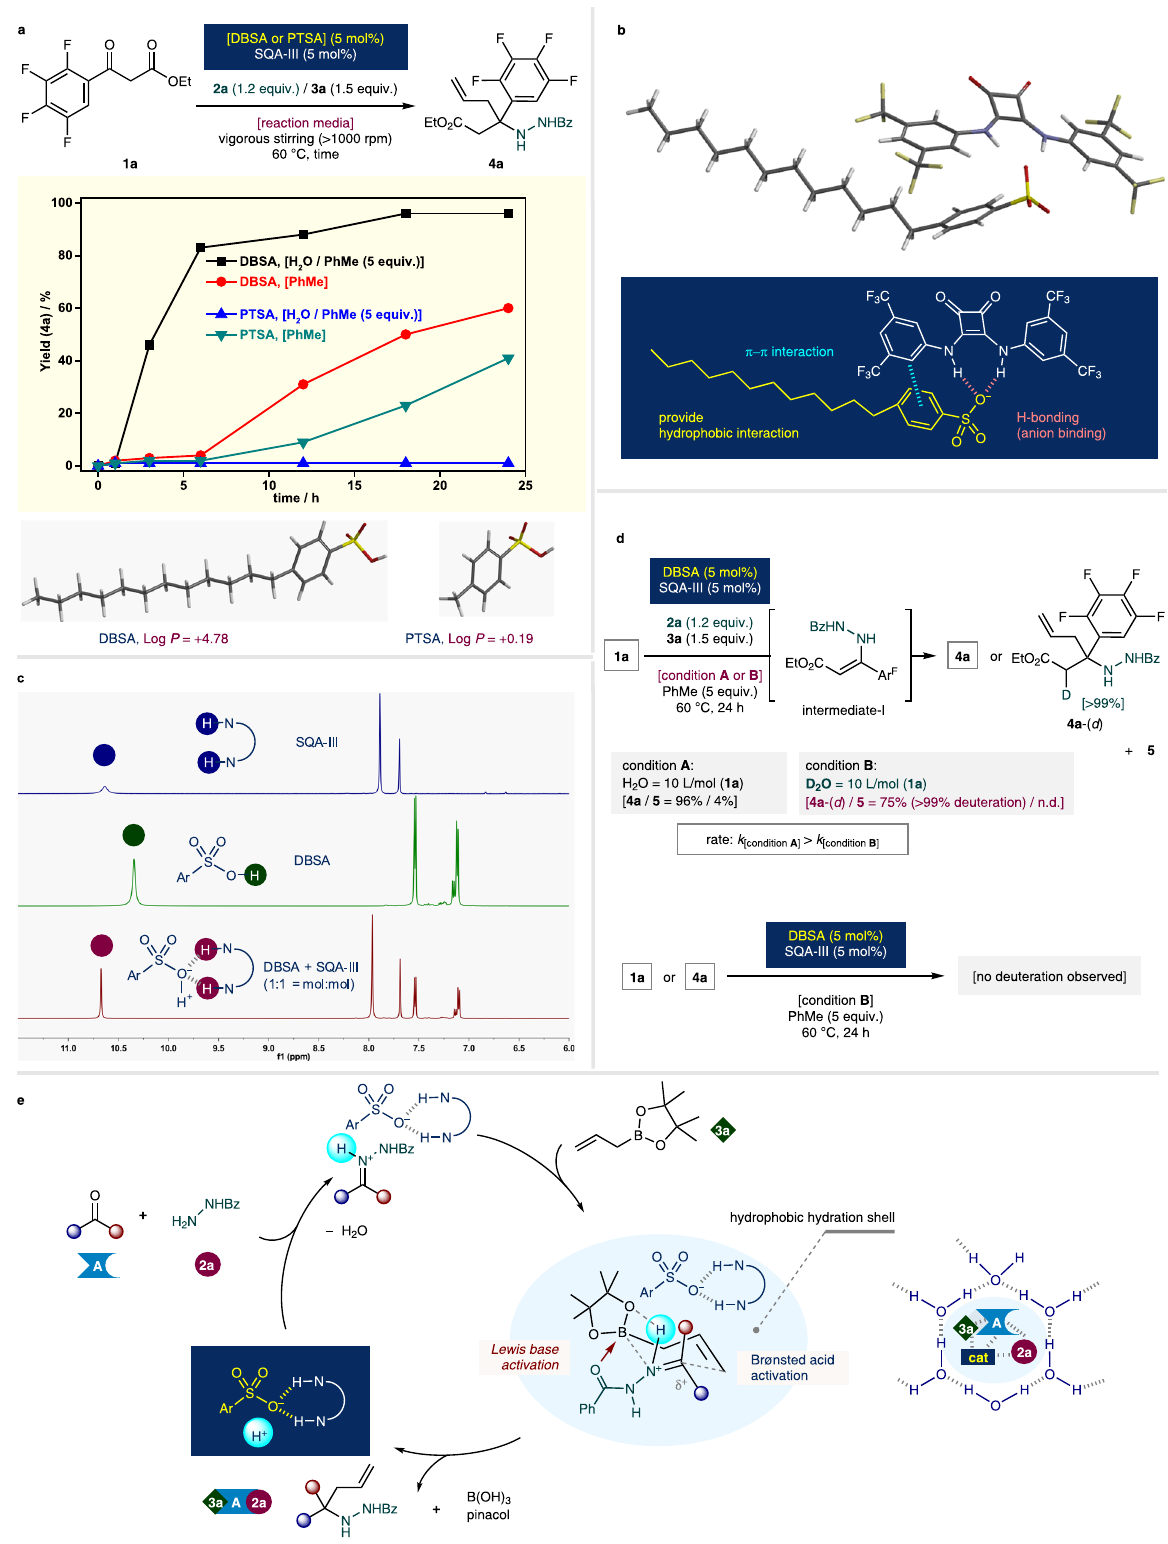
Fig. 7 Mechanistic investigation. a Reaction progress and calculated Log P values of the acid catalysts. b Complex of SQA-III and sulfonate anion of DBSA (DFT, B3LYP, equilibrium geometry of the ground state in PhMe, 6-31G*). c 1 H NMR spectra of the complexation of DBSA and SQA-III. d Reaction media isotope effect. e Putative catalytic cycle. A = carbonyl compound; Ar = 4-dodecylphenyl; Ar F = 2,3,4,5-tetra fl uorophenyl; Bz = benzoyl; cat = DBSA and SQA-III; Et =